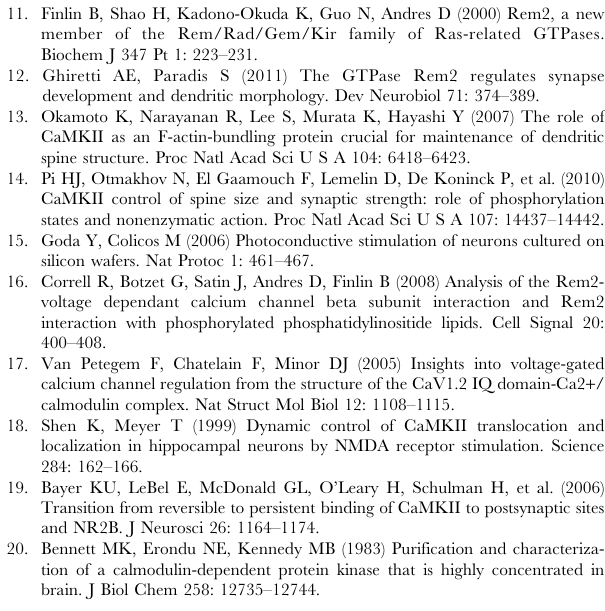
Figure S4 Convolution filtering of acquired images. ( A ) The convolution filter used here was a 5 6 5 matrix applied to each pixel of the image. The value of the pixel was multiplied by 24, then the surrounding 24 pixel values were subtracted. The resulting pixel value was output to a new image. Because this is an edge-detection algorithm, we avoided drawing ROIs that included an edge, either the cell membrane or the nuclear membrane. ( B ) Images taken before and after stimulation (upper left and upper right, respectively) show the background variation in pixel value. Bottom left and right images depict the upper images following application of the convolution filter. Note that variation in fluorescence background is removed while the signal from the puncta is left intact. (EPS) Movie S1 Rem2 and CaMKII redistribute together. Cultured hippocampal neurons cotransfected with GFP-Rem2 and mRuby-CaMKII were imaged using epifluorescence every 5 seconds for 7 minutes. Stimulation with 100 m M glutamate/ 10 m M glycine occurred at 120 seconds and was 60 seconds long (denoted by yellow ‘‘Glutamate/glycine’’ in the upper left corner of the video).